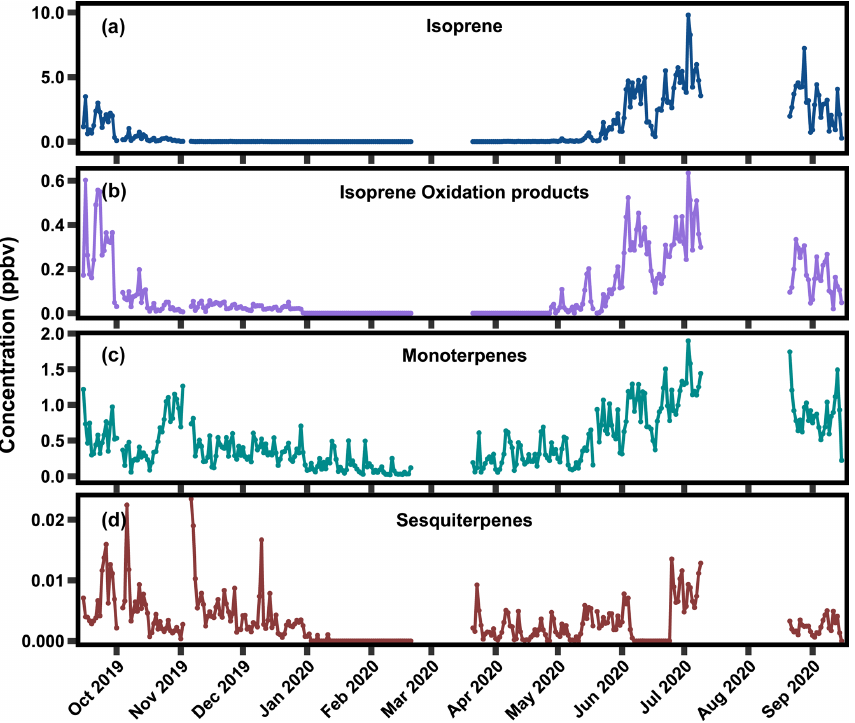
Figure 3. The 24h average concentrations of (a) isoprene, (b) isoprene oxidation products (methyl vinyl ketone and methacrolein), (c) sum of monoterpenes, and (d) sum of sesquiterpenes between 15 September 2019 and 15 September 2020.